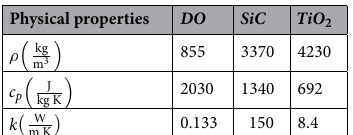
Table 2. Thermophysical properties of TiO 2